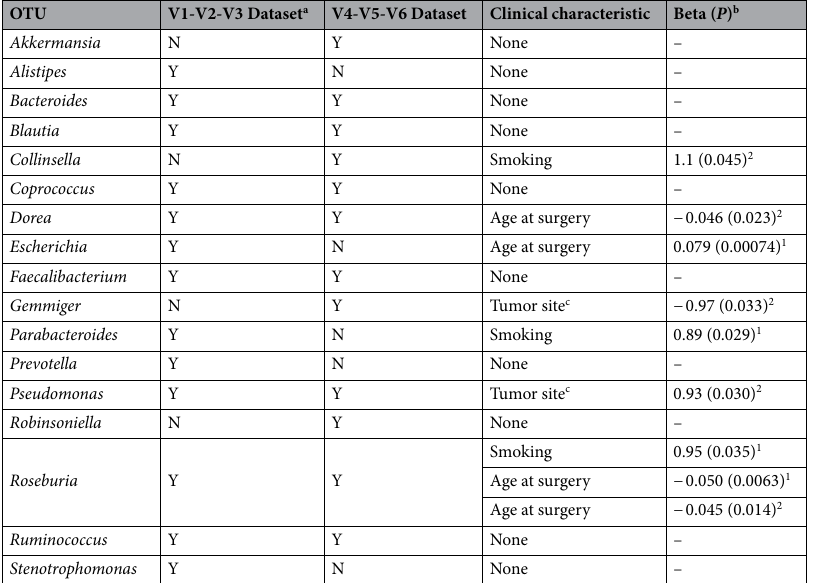
Table 2. Association of operational taxonomic units (OTUs) and clinical characteristics. OTUs observed in > 25% of samples and with mean relative abundance > 1%, and associations between the clr-transformed relative abundance and patient characteristics, by multivariate linear regression. a Sequence data from the six hypervariable regions were aggregated into two datasets (V1-V2-V3 and V4-V5-V6) and analyzed separately. b Beta and P -value from 1 V1-V2-V3 or 2 V4-V5-V6 datasets. c